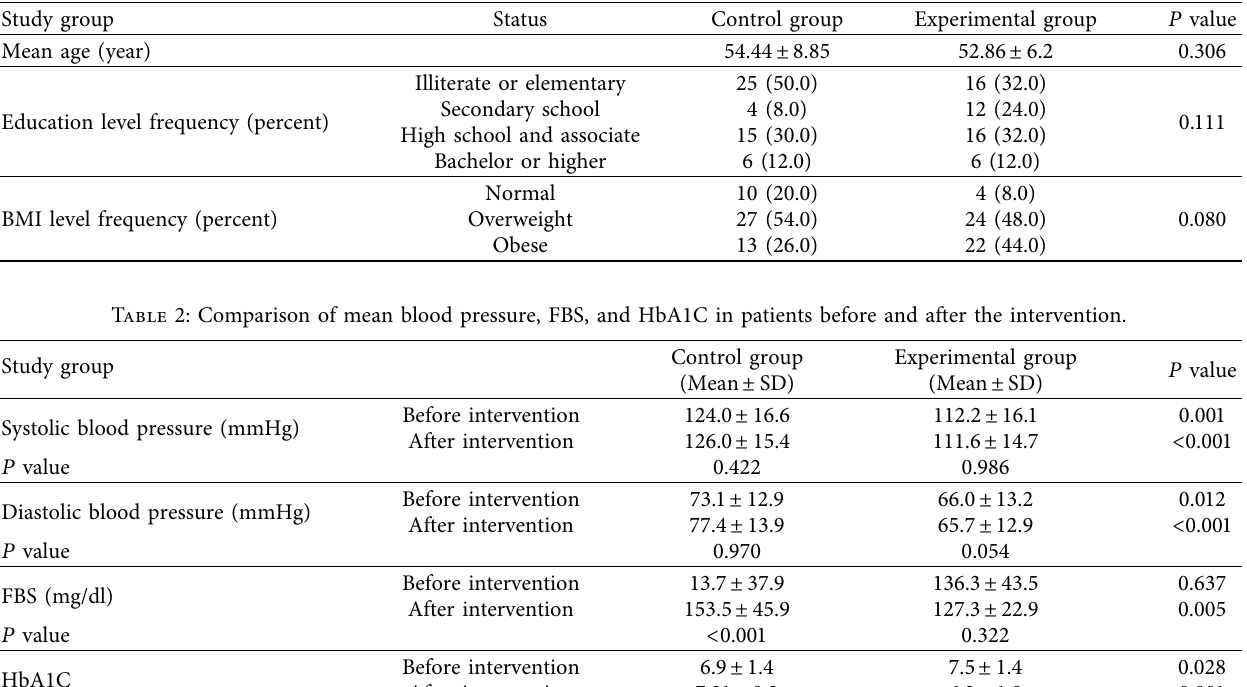
Table 1: Comparison of demographic characteristics in study participants.